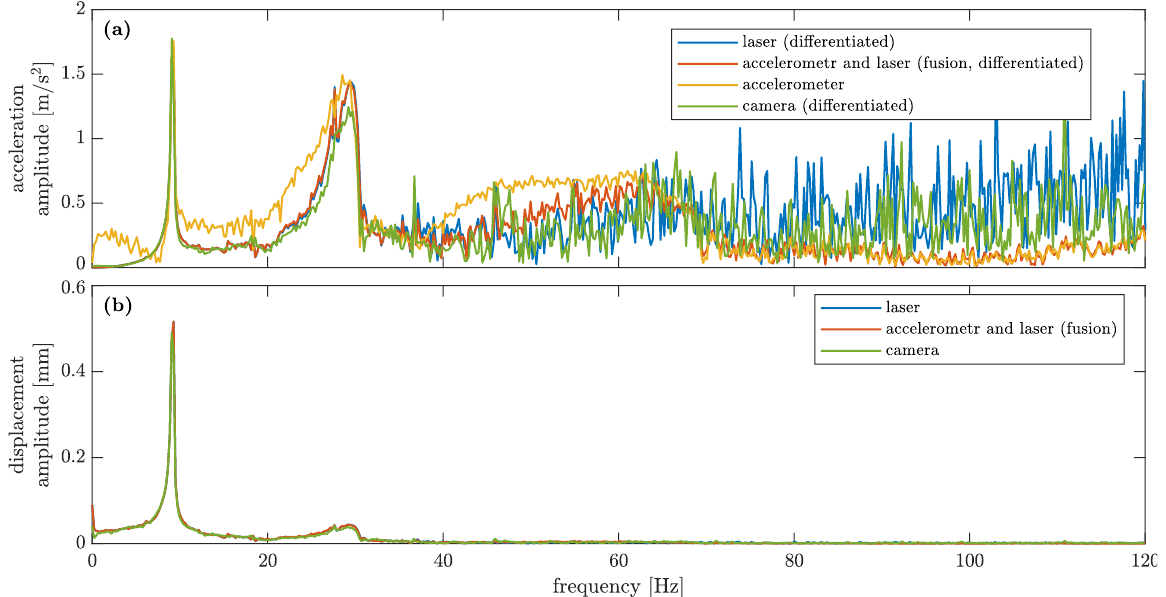
Figure 10. Comparison of amplitude spectra of ( a ) accelerations and ( b ) corresponding displacements of Node 2 obtained for various types of sensing of the structural